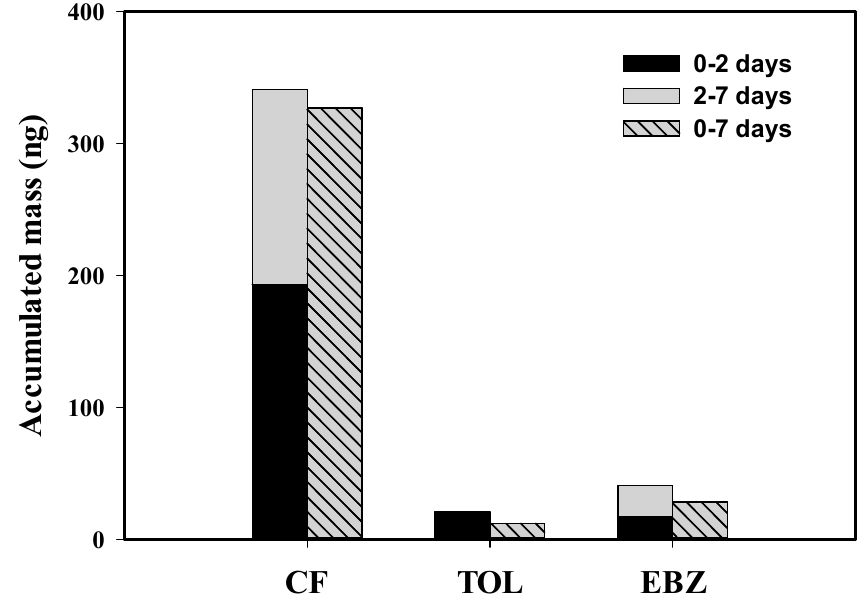
Figure 5. Accumulated masses of three VOCs on the solid ceramic dosimeter in the treated industrial wastewater.